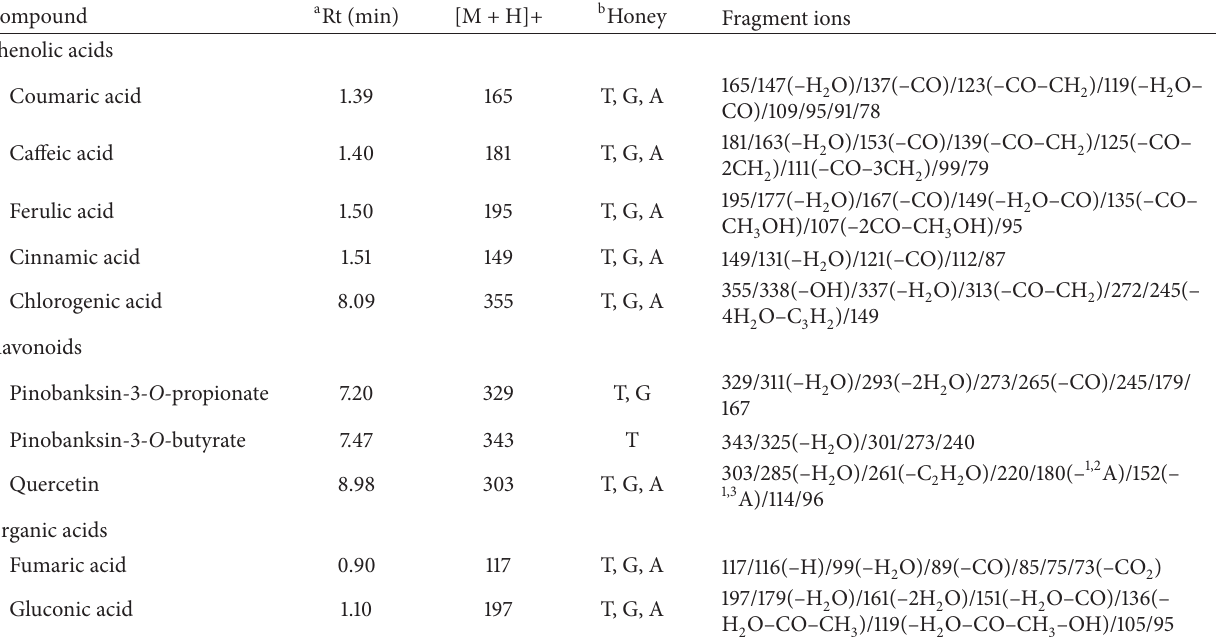
Table 3: Phenolic acids, flavonoids, and organic acids detected from honey samples.